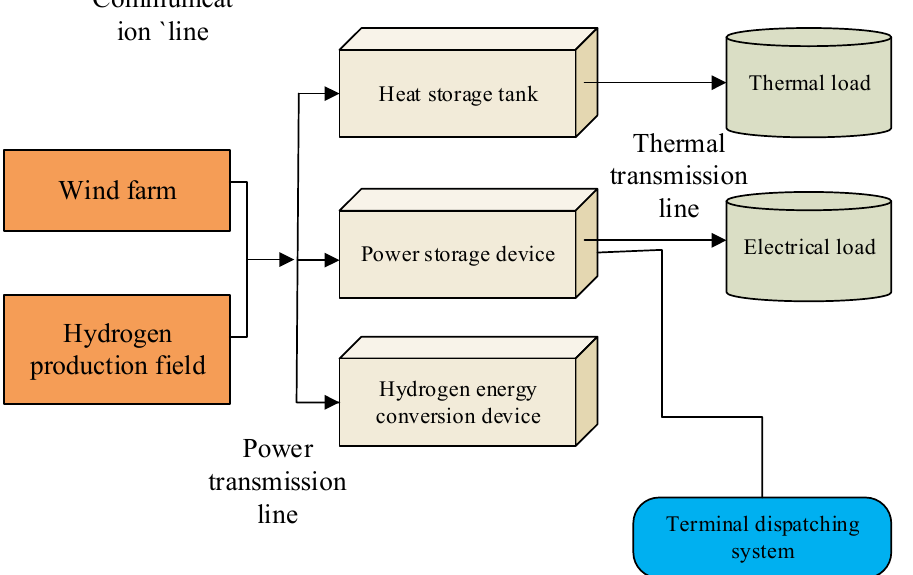
Figure 1. Structural diagram of wind-hydrogen integrated energy system.